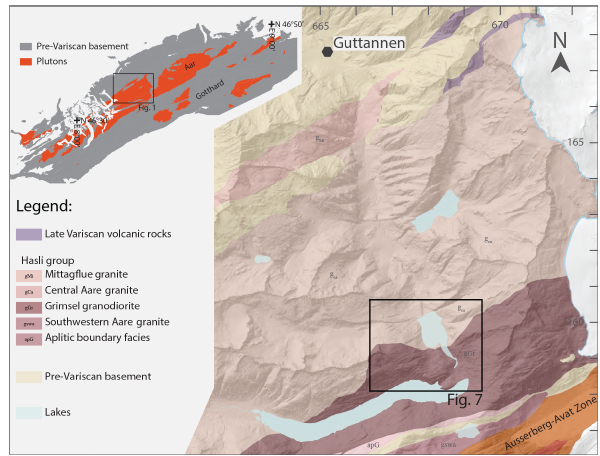
Figure 1. Geological map of the study area (modified after Berger et al., 2017). The coordinate system of the inset map is given in WGS84, whereas the coordinates of the local geological map are given in the Swiss coordinate system